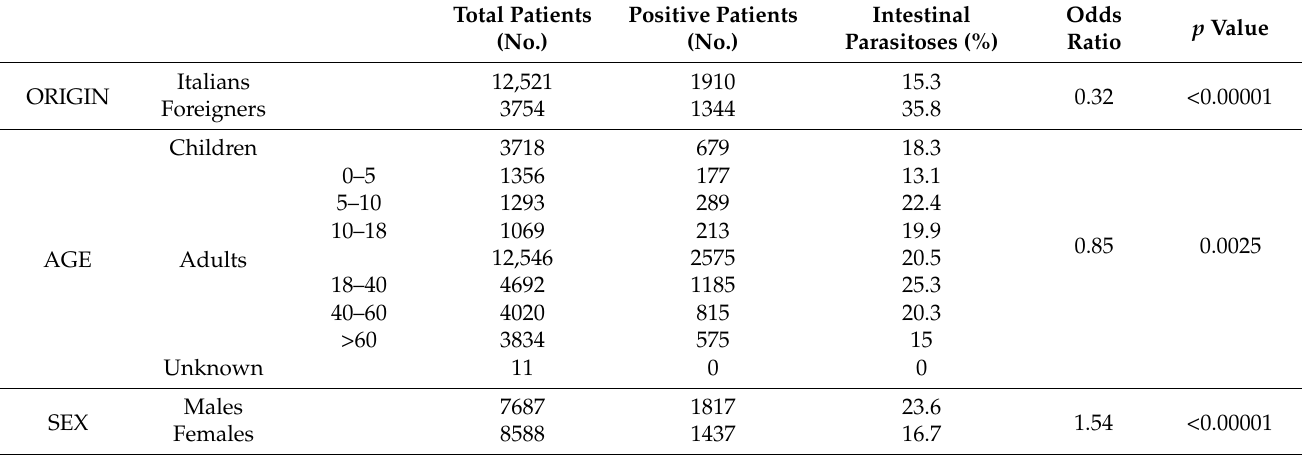
Table 1. Statistical analysis concerning the origin, age, and sex of the patients diagnosed with intestinal parasitosis. Total Patients Positive Patients Intestinal (No.) (No.) Parasitoses (%)